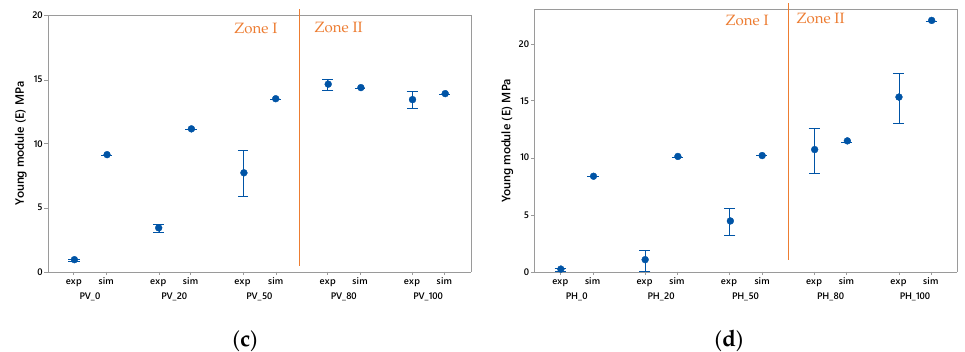
Figure 6. Comparative results of the experimental study (exp) and the simulation carried out (sim) for the yield stress: ( a , b ) cylindrical specimens; ( c , d ) horizontal specimens.